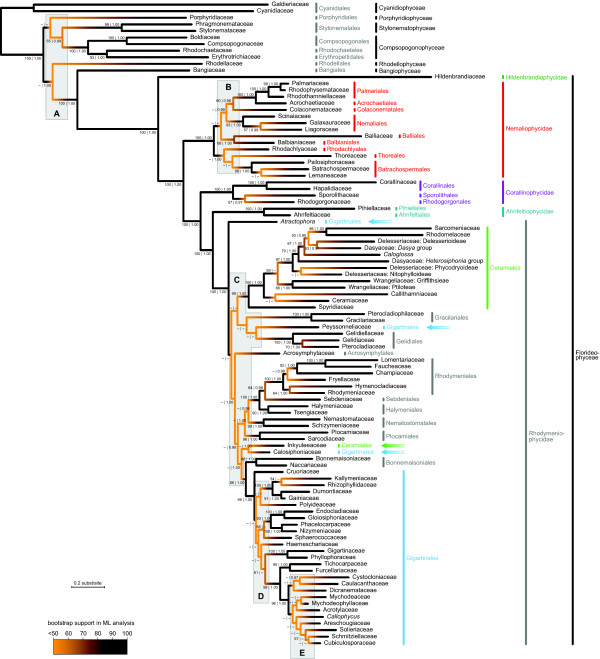
Red algal tree of life with current taxonomic classification. The tree was reconstructed using Bayesian phylogenetic inference of DNA data mined from GenBank (Figure 1). Branch colors indicate statistical support of the clades: whereas black branches are strongly supported, the orange parts of the tree are poorly resolved. Intermediate colors represent intermediate support (see gradient legend). Five poorly supported regions are indicated with gray boxes (A-E). Numbers at nodes indicate branch support given as bootstrap values from maximum likelihood analysis before the vertical bar and Bayesian posterior probabilities after the vertical bar. Values are only shown if they exceed 50 and 0.95, respectively.